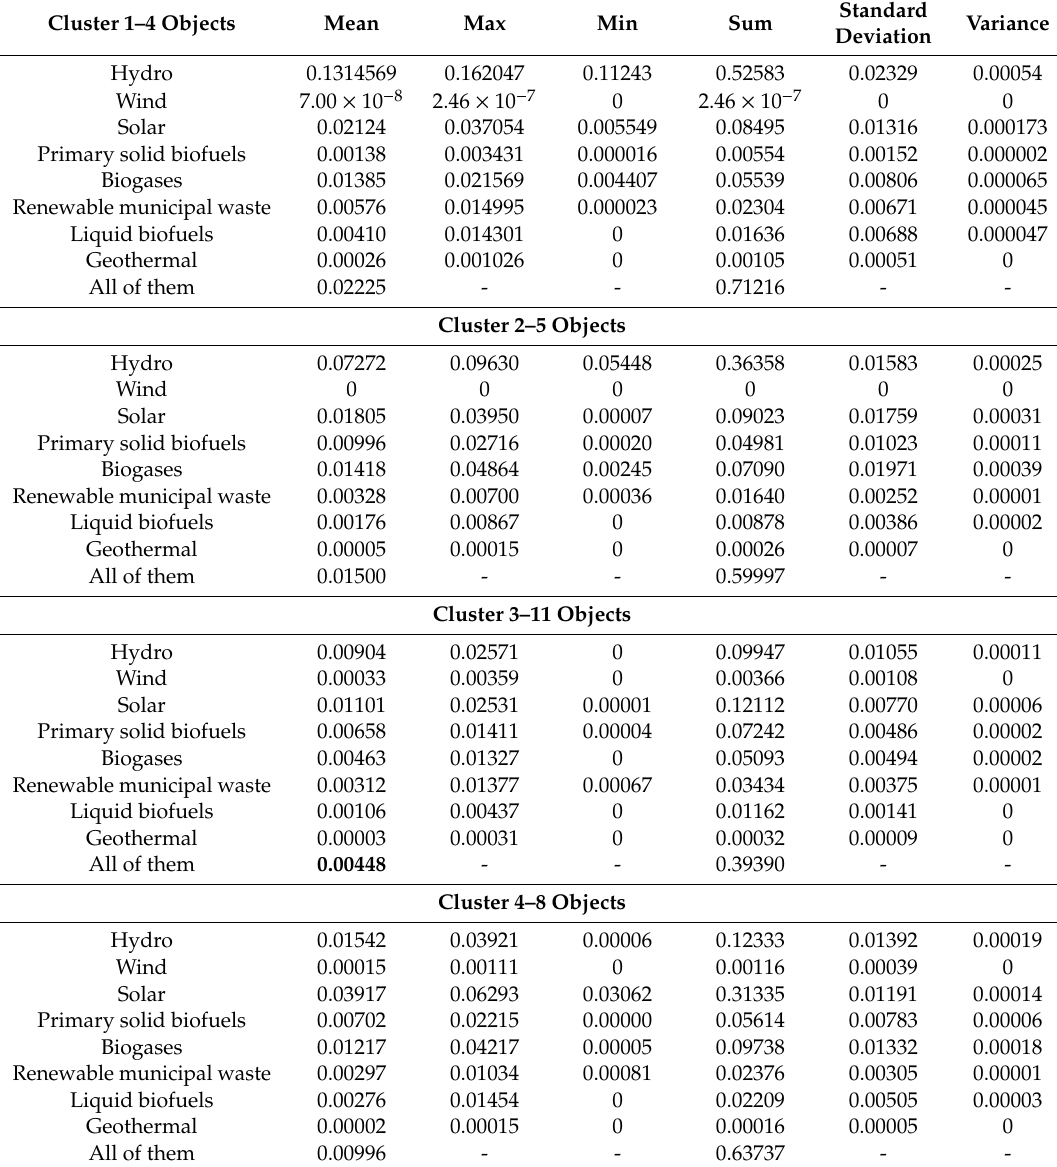
Table 18. Elements of clusters with distances from centers (own